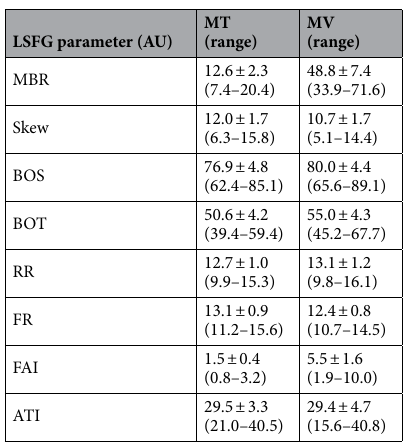
Table 2. LSFG parameters of 111 eyes. The values are represented as mean ± standard deviation. ATI acceleration time index, AU arbitrary unit, BOS blowout score, BOT blowout time, FAI flow acceleration index, FR falling rate, MBR mean blur rate, MT MBR in tissue area, MV MBR in vessel area, RR rising rate.